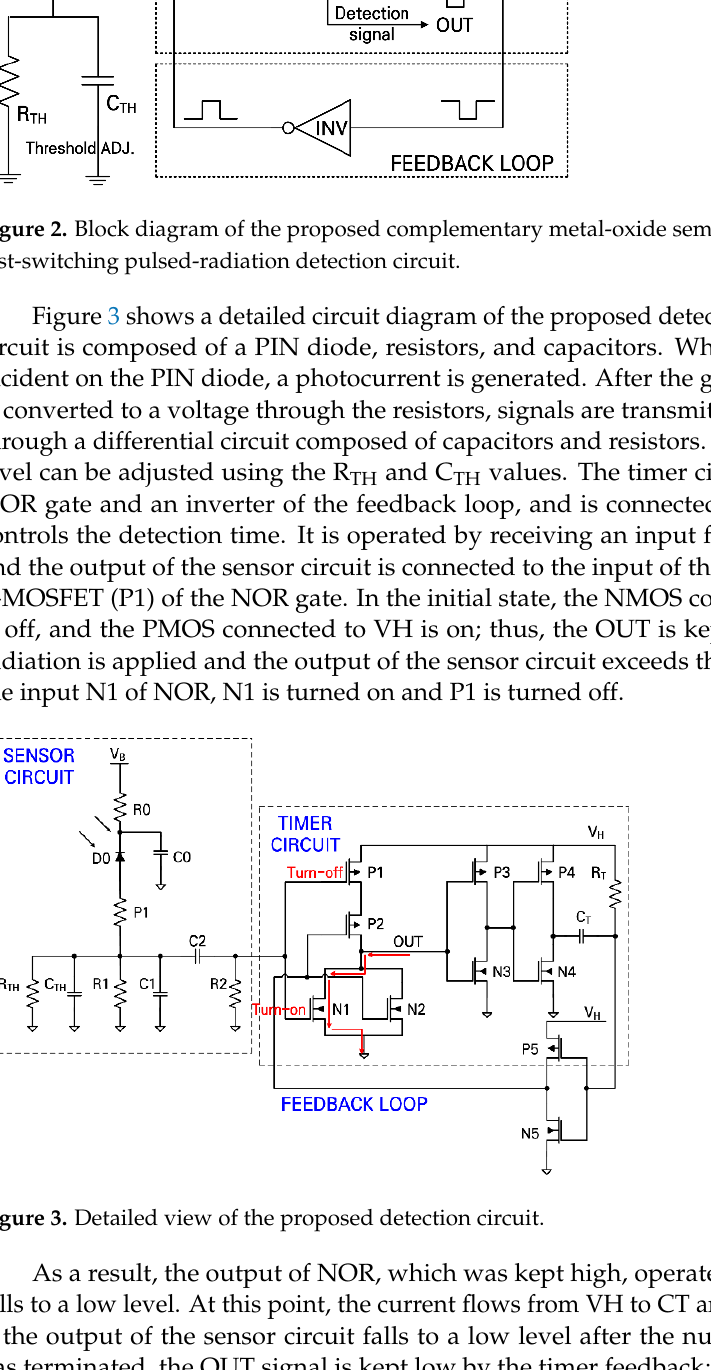
Figure 3. Detailed view of the proposed detection circuit.